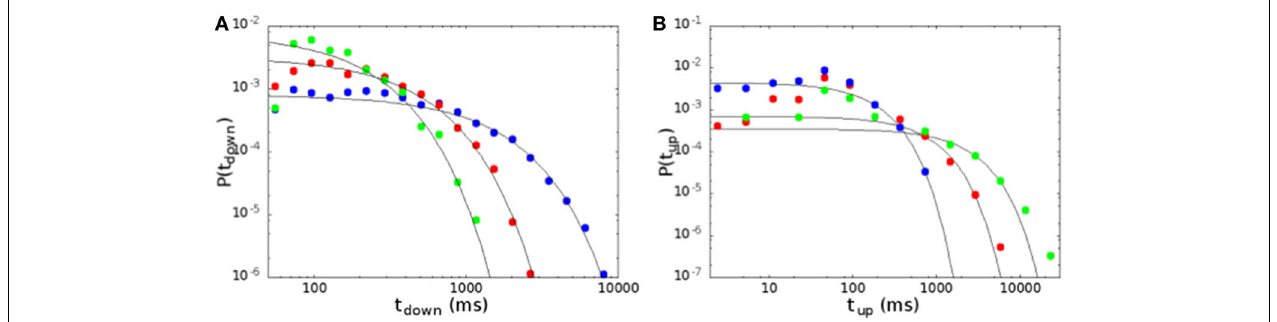
FIGURE 8 | Distribution of the durations of down (A) and up (B) states, for the same parameters of Figure 6. Continuous lines are exponential fits to the distributions. Durations of down states are well fitted by an exponential, while durations of up states show some deviations both at short and at large times.